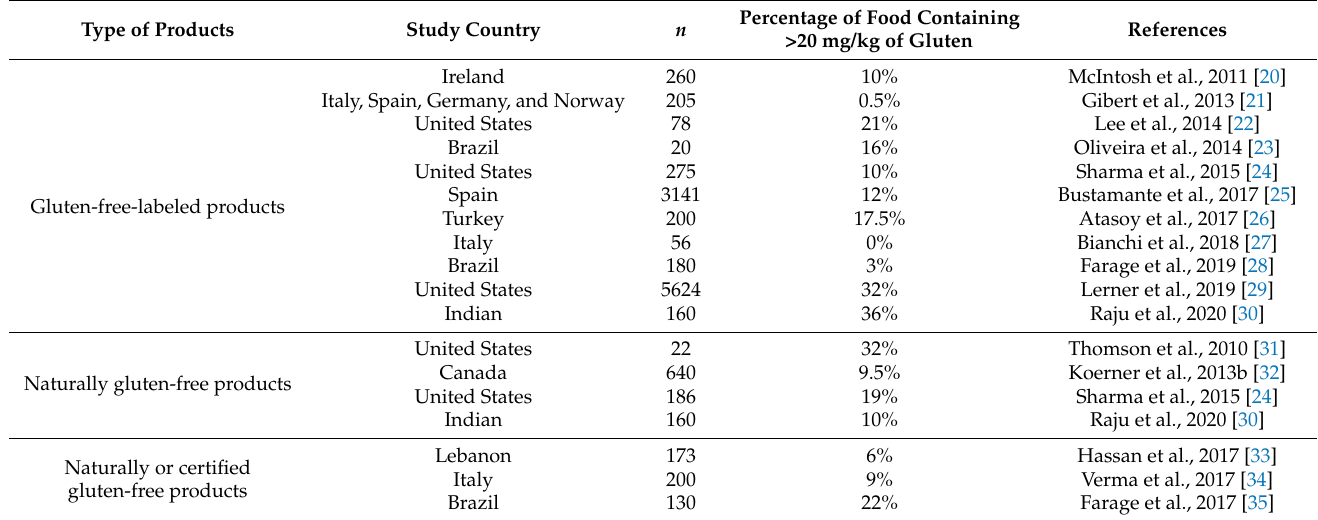
Table 1. Studies on the rate of gluten contamination in natural and certified gluten-free foods, as well as food service